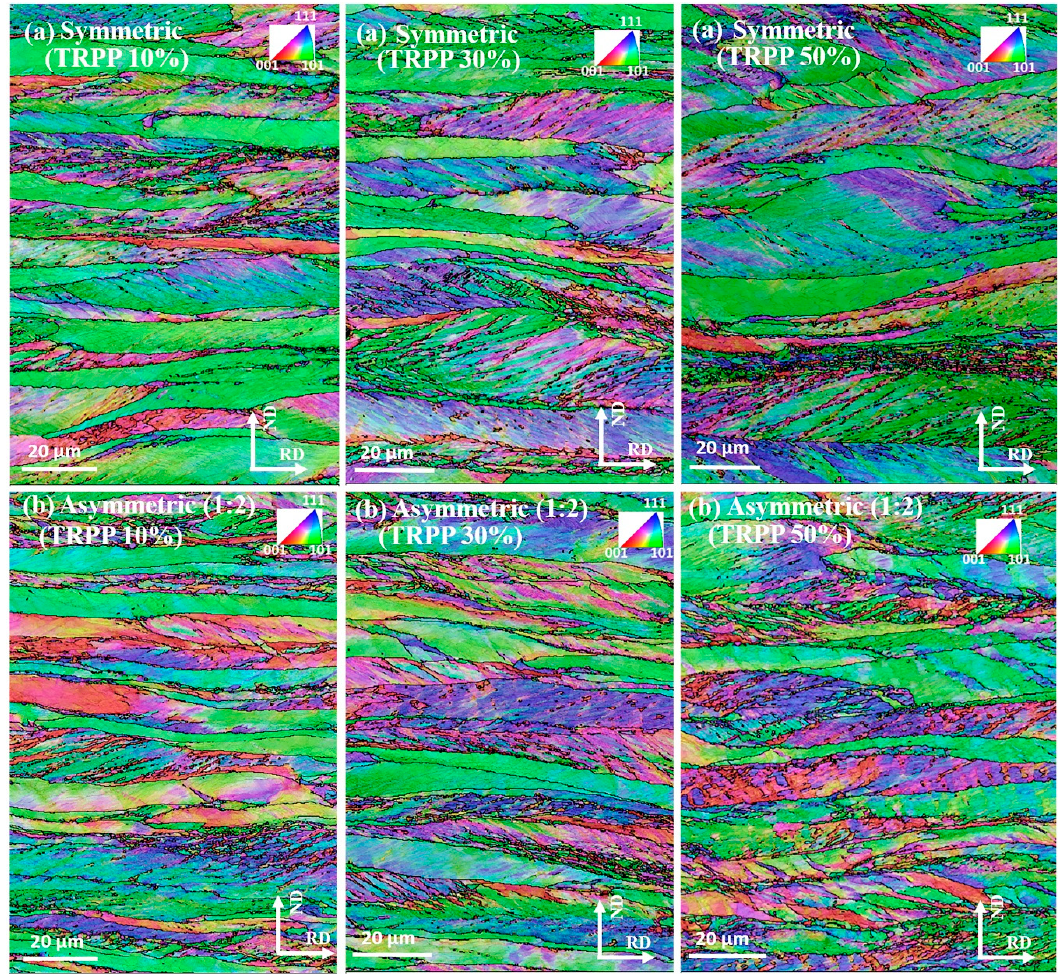
Figure 9. IPF maps (RD axis projection) for medium strain (75%) in ( a ) symmetric and ( b ) asymmetric (1:2) mode with TRPP values of 10, 30, and 50%.